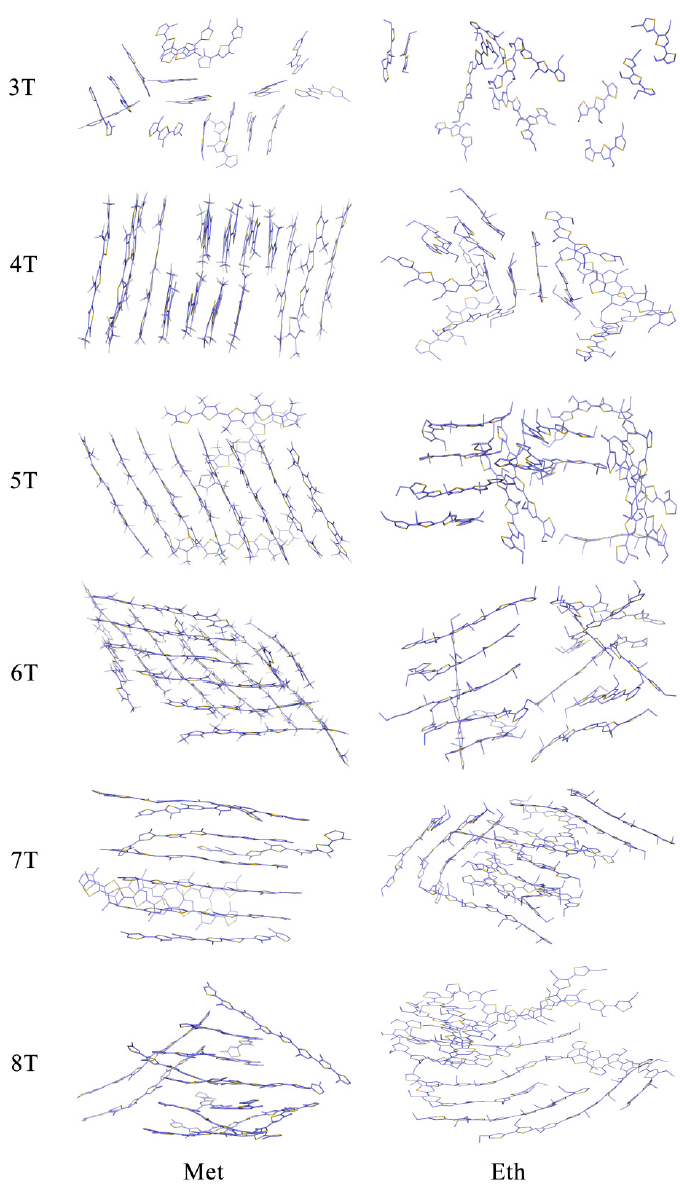
Figure 4. The packing pattern of the methyl- and ethyl-substituted P3AT molecules, respectively.